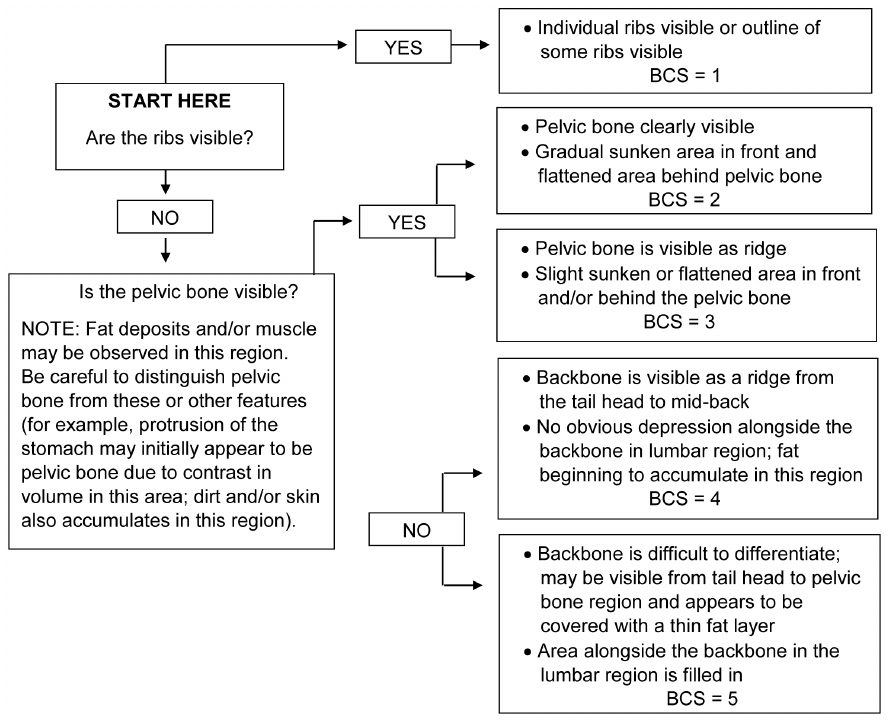
Figure 4. Body condition scoring flow chart for female African elephants.